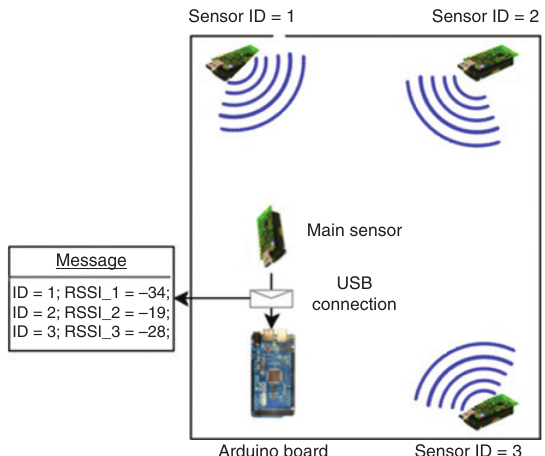
Figure 5: The Positioning